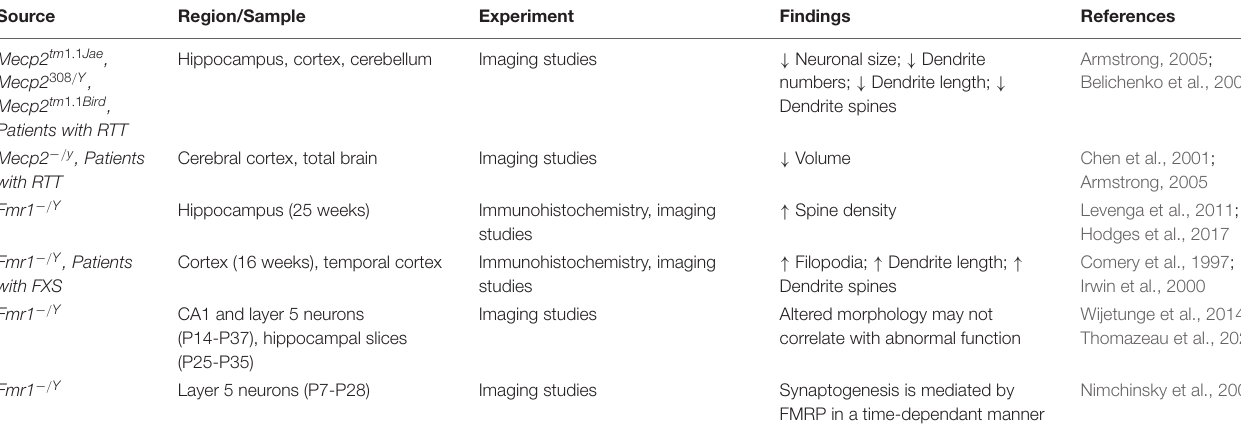
TABLE 2 | Morphological correlates in Rett syndrome and Fragile X